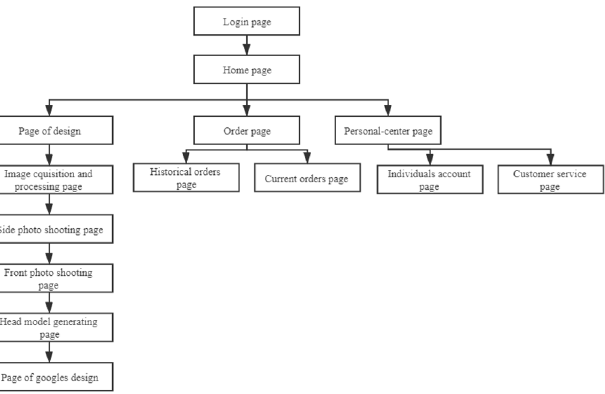
Fig. 19. The page frame diagram of the mobile APP.